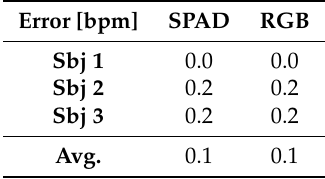
Table 6. Average errors in determination of heart rate in one-minute